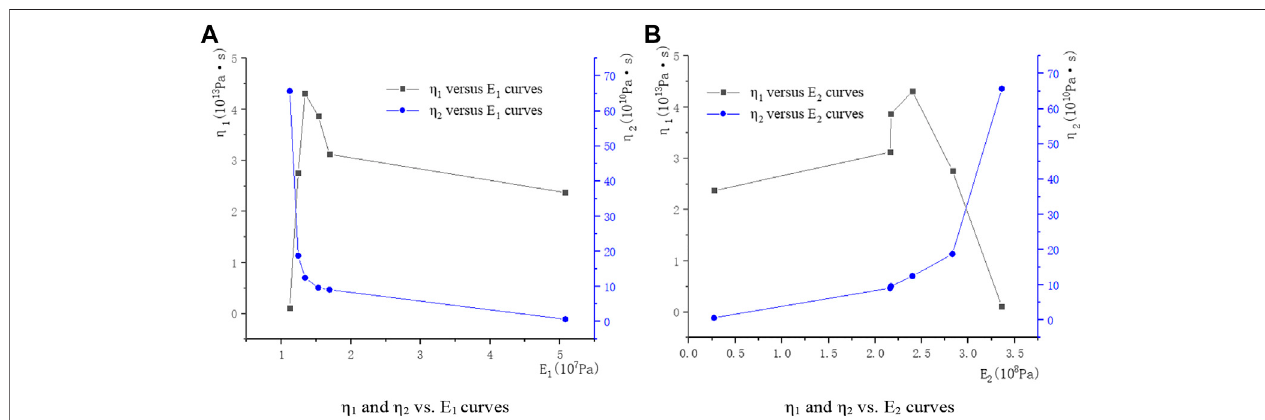
FIGURE 5 | η 1 and η 2 versus E 1 and E 2 curves. (A) η 1 and η 2 vs. E 1 curves. (B) η 1 and η 2 vs. E 2 curves.